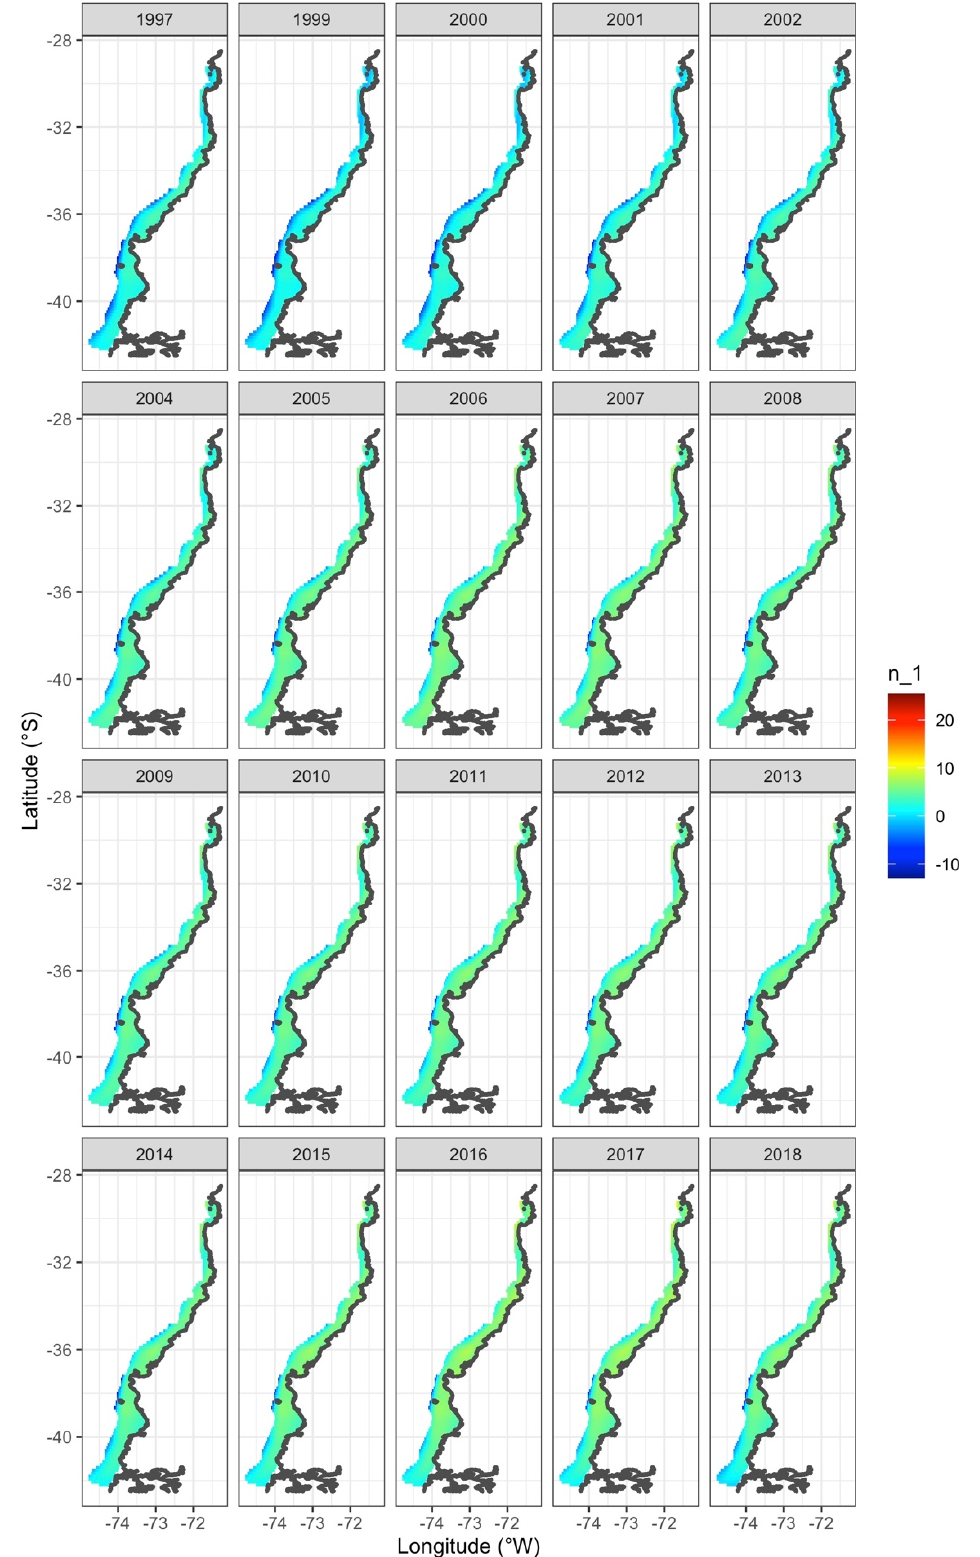
Figure 5. Spatiotemporal distribution of the abundance of Chilean hake juvenile of age 1, from 1997 to 2018 (Model M1.8, Table 2).